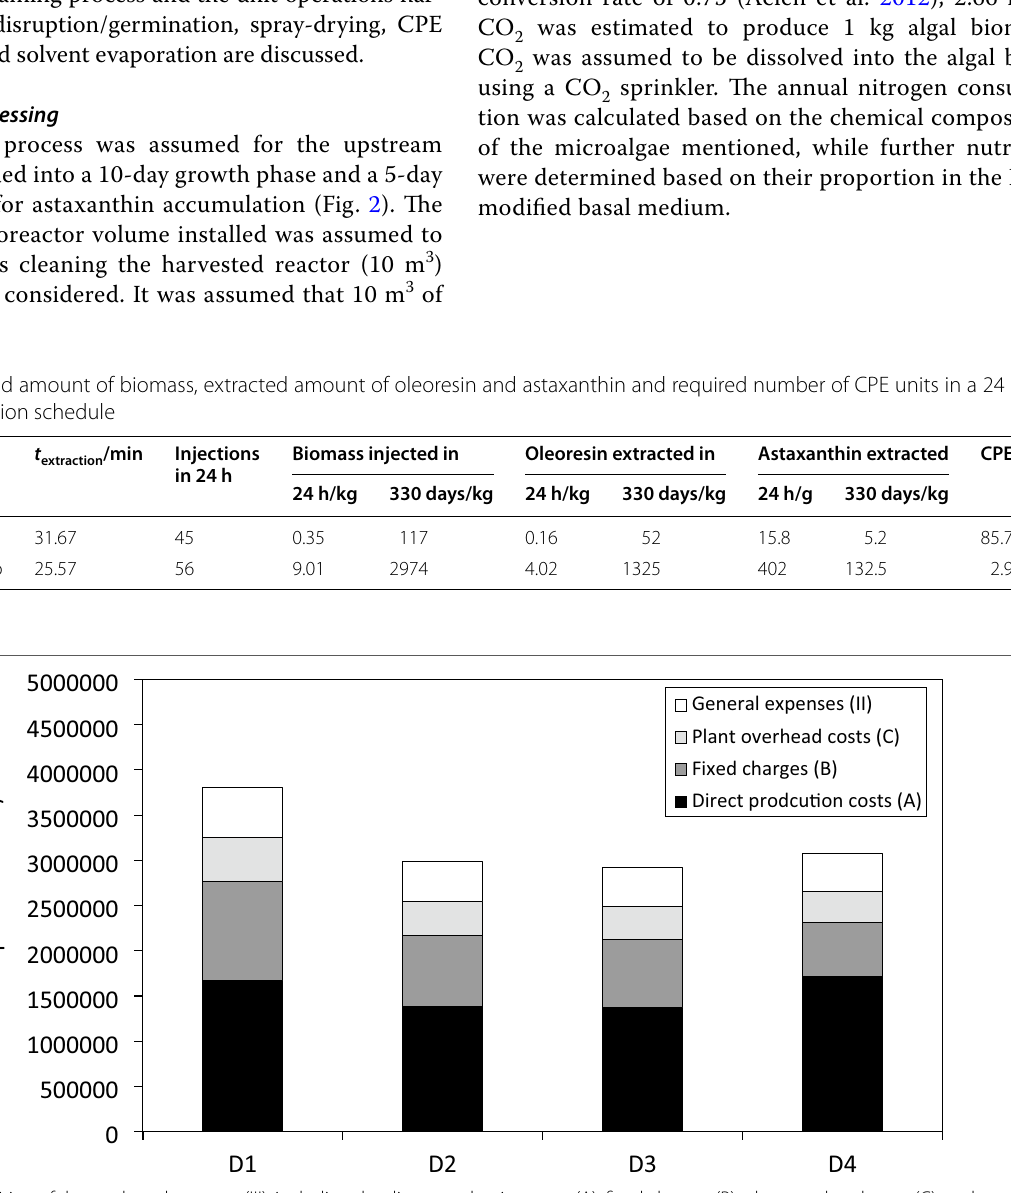
Fig. 5 Composition of the total product costs (III), including the direct production costs (A), fixed charges (B), plant overhead costs (C), and general expenses (II) for the four downstream scenarios D1, D2, D3, and